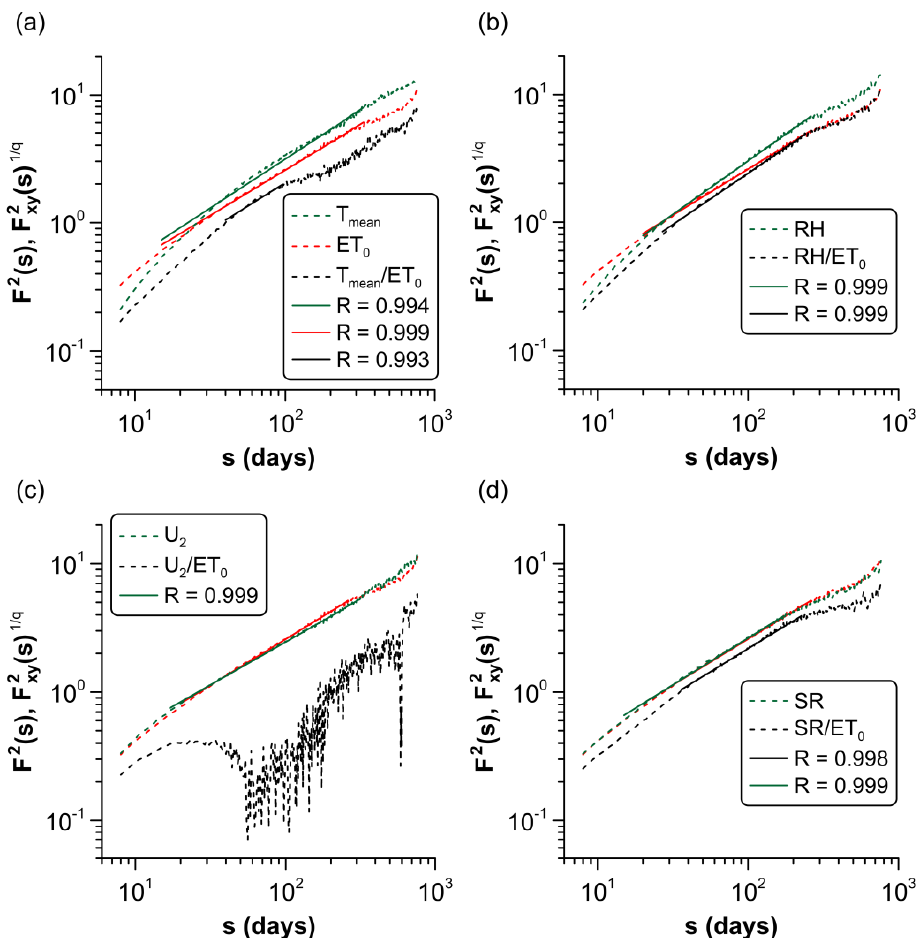
Figure 5. Detrended variance and covariance functions for q = 2 of meteorological variables with ET 0 (dashed lines) and their linear fits (solid lines). ( a ) T mean – ET 0 . ( b ) RH – ET 0 . ( c ) U 2 – ET 0 . ( d ) SR – ET 0 .